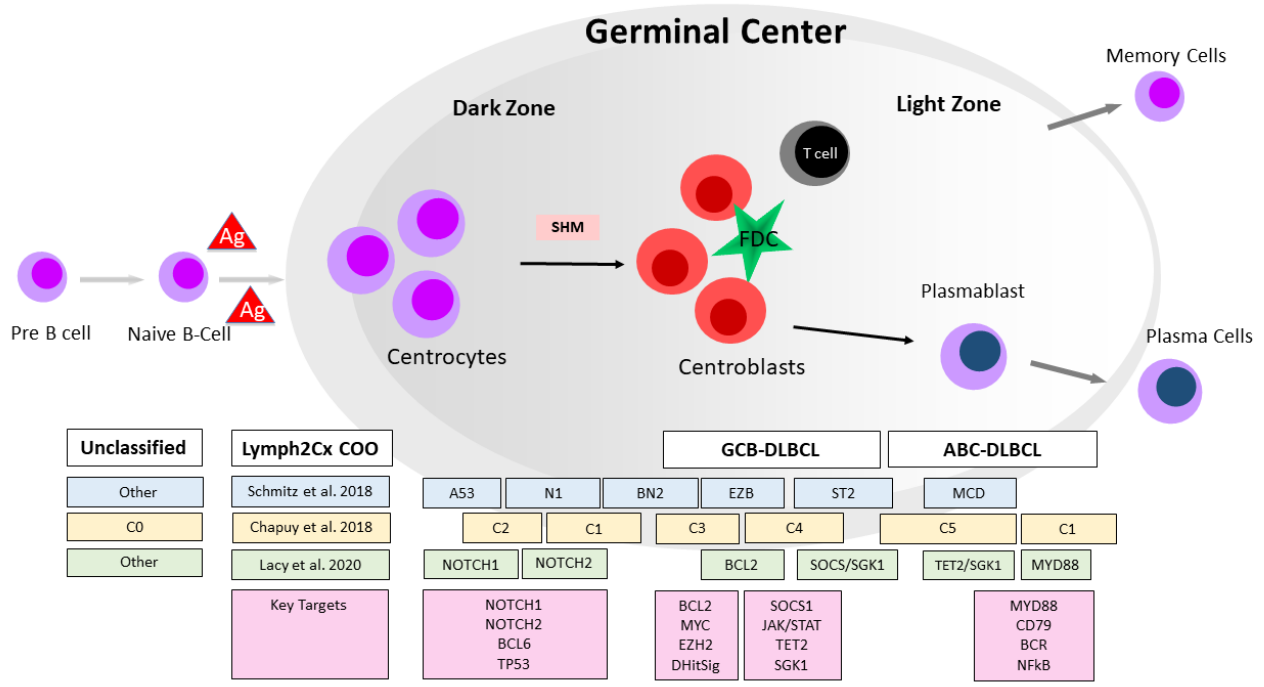
Figure 2. Schematic presentation of maturating and differentiating pathways in germinal centers including some biological characteristics of GCB-like and ABC-like lymphomas derived from different compartments of the GC. The lower panel shows the more recently proposed algorithms in the molecular subclassification of DLBCL including their main defining genes.